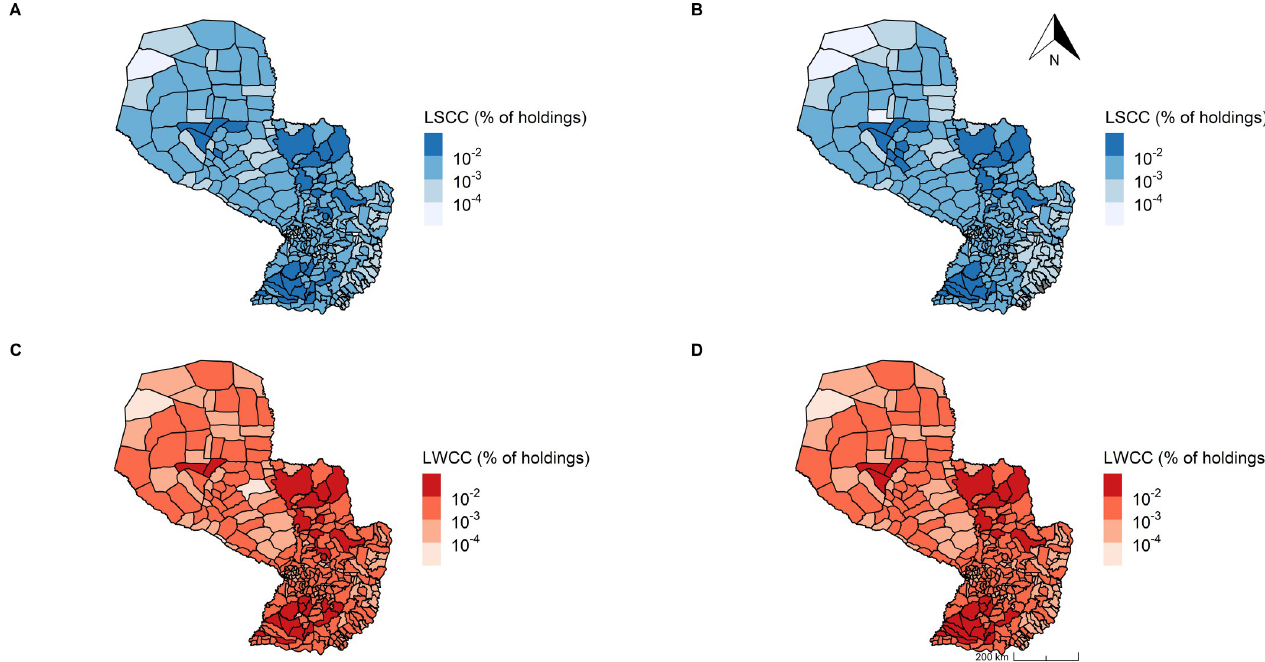
Fig 3. Spatial distribution of the holdings in the largest strongly and weakly connected components. Largest strongly connected component (LSCC) (A): all cattle, (B): cows and largest weakly connected component (LWCC) (C): all cattle, (D): cows for the global network (aggregated nodes and links from 2014 to 2018). Percentage of holdings in each district corresponds to the number of holdings belonging to the largest component over the size of that largest